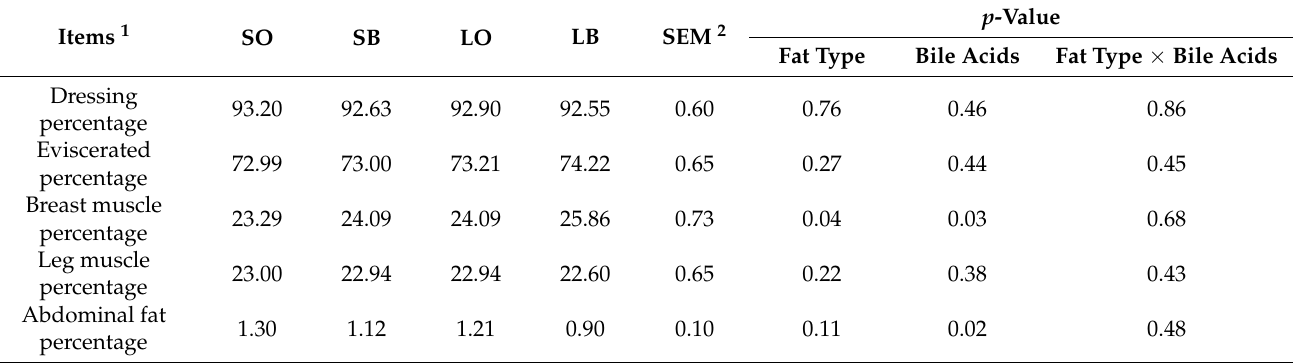
Table 4. Effects of bile acids supplemented in diet included with different types of fat on carcass characteristics in broiler chickens